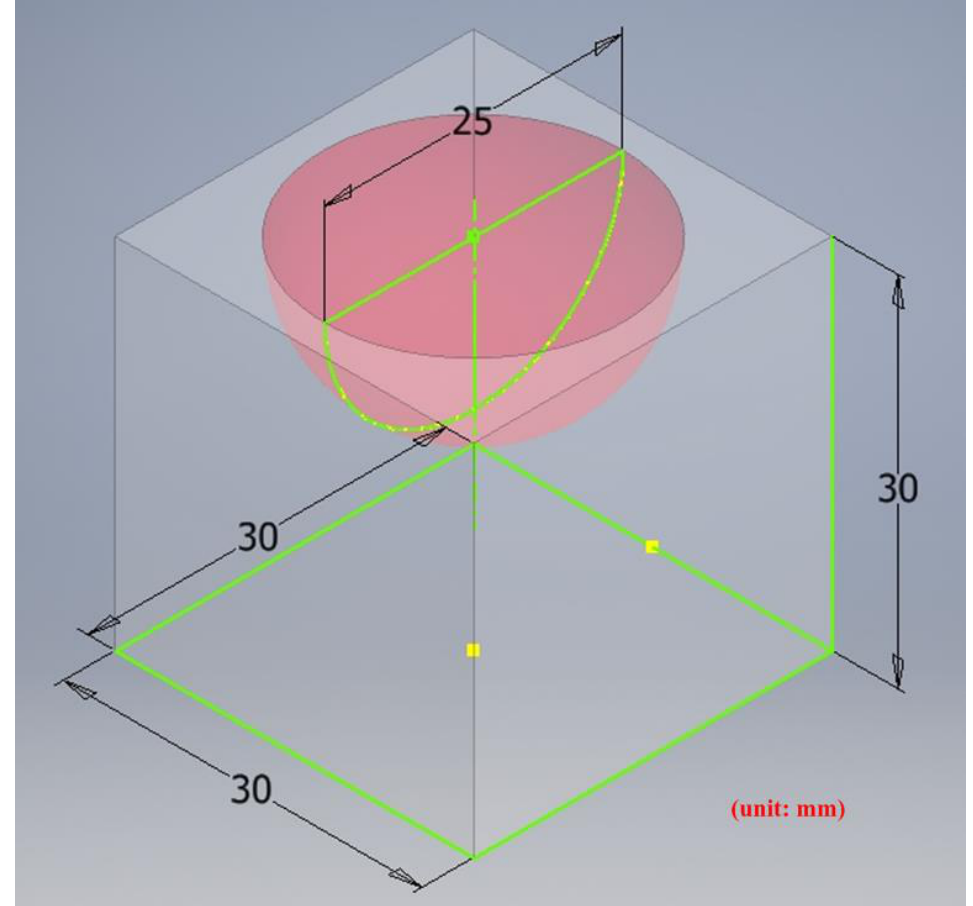
Figure 9. The dimension of concave circle processing.